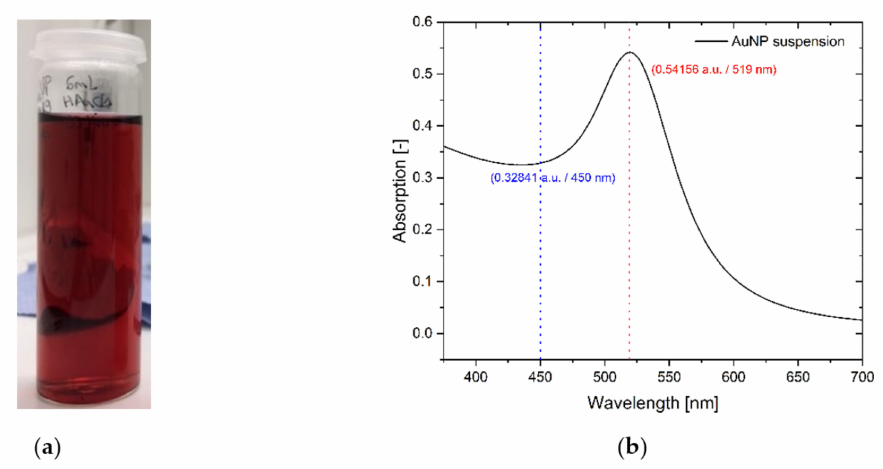
Figure 1. Synthesised gold-nanoparticles (AuNPs), ( a ) image of the AuNPs suspension. ( b ) UV-Vis absorption spectrum of a AuNPs suspension with a maximum at 519 nm (red dotted line) and the reference intensity at 450 nm (blue dotted